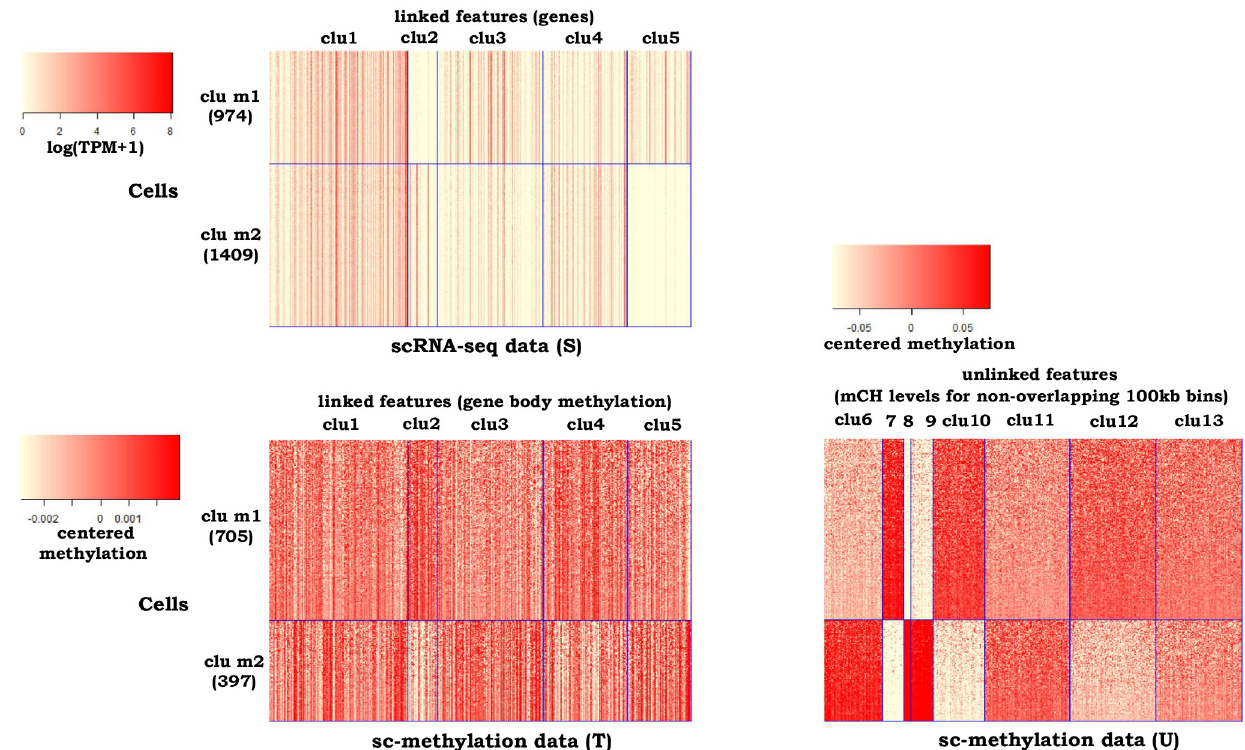
Fig 4. Heatmaps of the clustering results by couple CoC+ for example 3. “clu m” represents the matched cell cluster across the source data and the target data. We obtained the centered methylation level by first centering the data matrix by row and then centering the data matrix by column. Grey color in the heatmap of sc-methylation data corresponds to missing data. For better visualization, we randomly averaged every 15 cells within the same cell cluster to generate pseudocells for every heatmap.